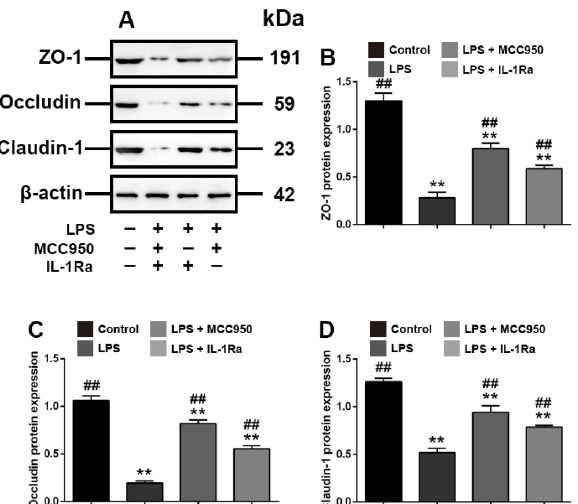
Figure 5. Interference with NLRP3 and IL-1 β is associated with tight junction in IPEC-J2 cells in vitro. PEC-J2 cells were treated with vehicle, LPS (2 μ g/mL), MCC950 (10 μ m) and IL-1Ra (10 ng/mL) for 48 h. Western blot analyses of tight-junction-related proteins. ( A ) Western blot analyses of tight-junction-related proteins; effect of LPS on ZO-1 ( B ), occludin ( C ) and claudin-1 ( D ) in IPEC-2 cells. β -Actin was used as an invariant control for equal loading. Blots are representative of three independent experiments with densitometry showing the mean ± s.d. ** p < 0.01 versus control. ## p < 0.01 versus